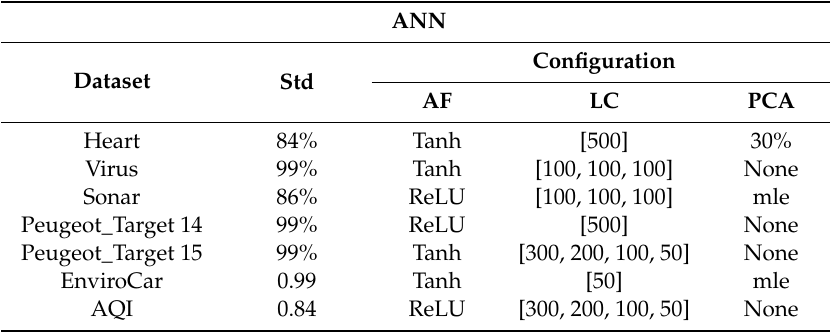
Table 16. Performance and configuration of ANN with StandardScaler normalization.